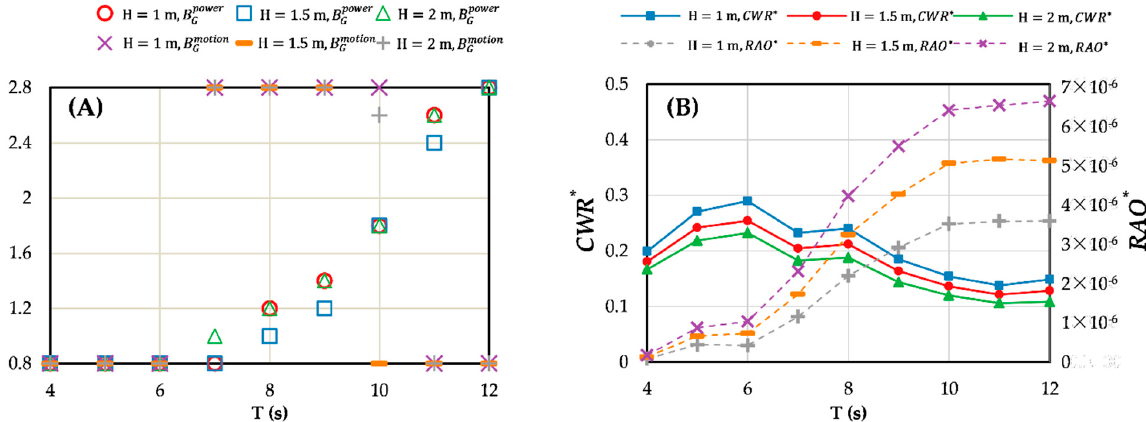
Figure 15. In fl uence of pre-charged pressure of accumulator on the performance of the hybrid system under wave height of 1.5 m. ( A ) Variation of CWR. ( B ) Variation of pitch motion RAO.